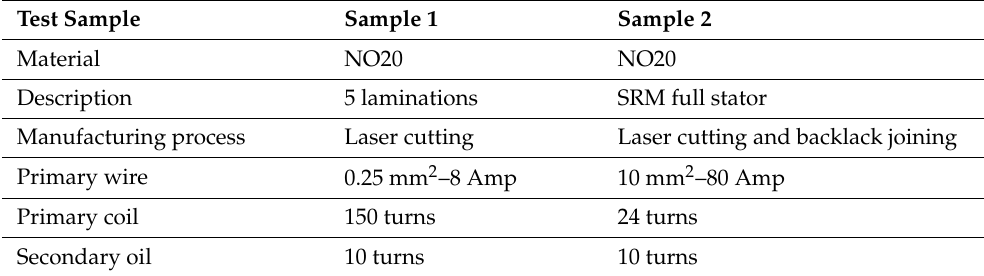
Figure 4. The measured core losses of the individual laminations: ( a ) with respect to magnetic flux density, ( b ) with respect to frequency. Table 3. Specifications of double coil test samples.